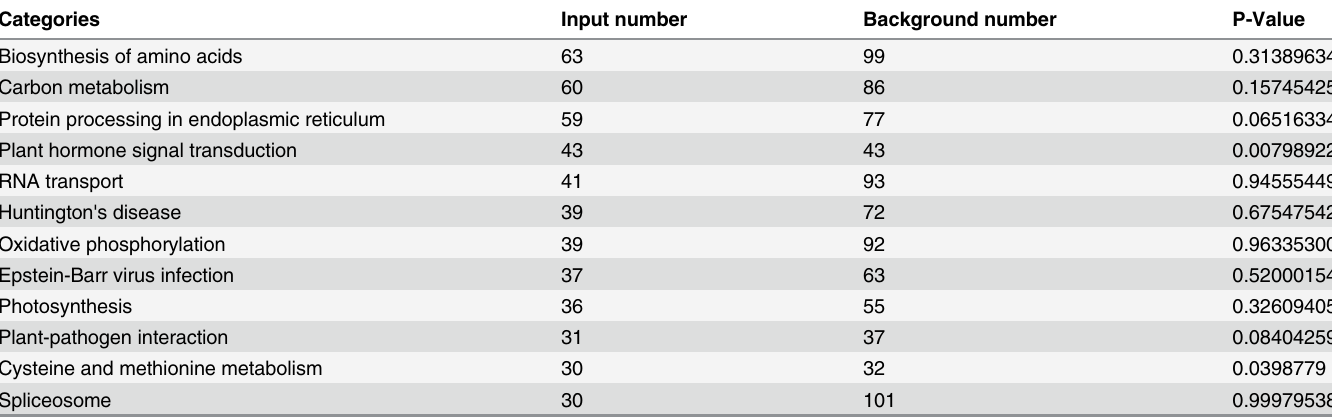
Table 2. The major distribution of the KEGG